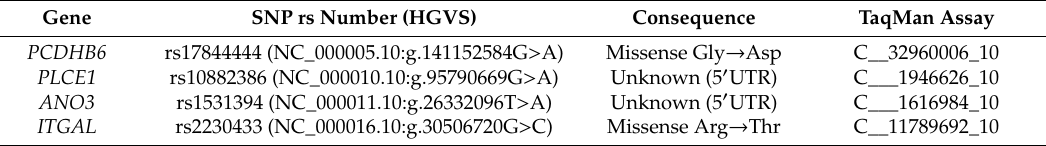
Table 2. Analyzed